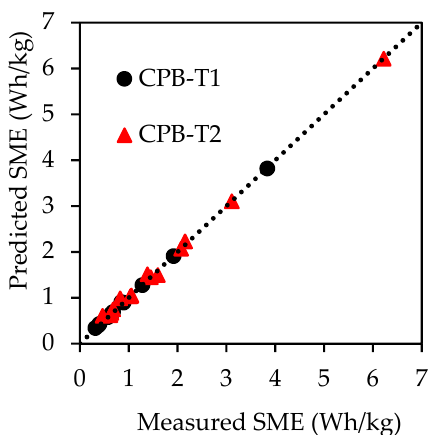
Figure 9. Comparison between measured and predicted SME for CPB-T1 and CPB-T2 mixtures prepared with tailings T1 and T2, respectively.